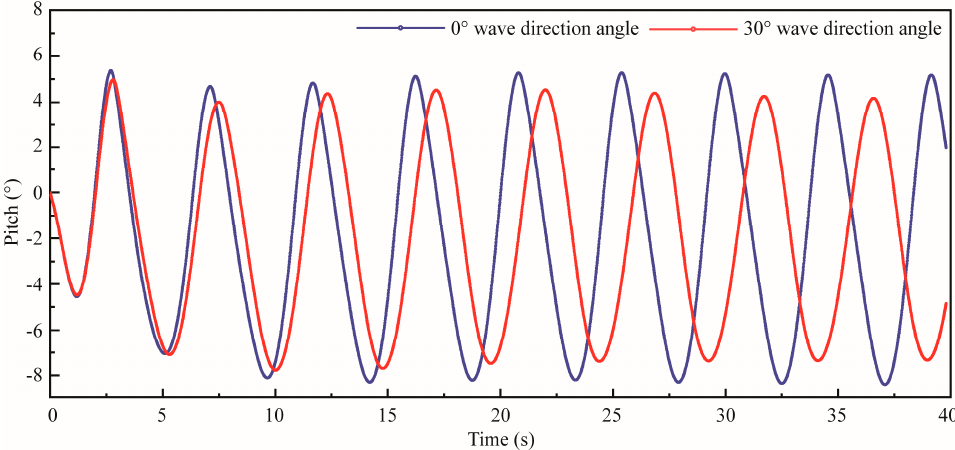
Figure 17. The pitch motion with different wave direction angles at 5 level sea state.